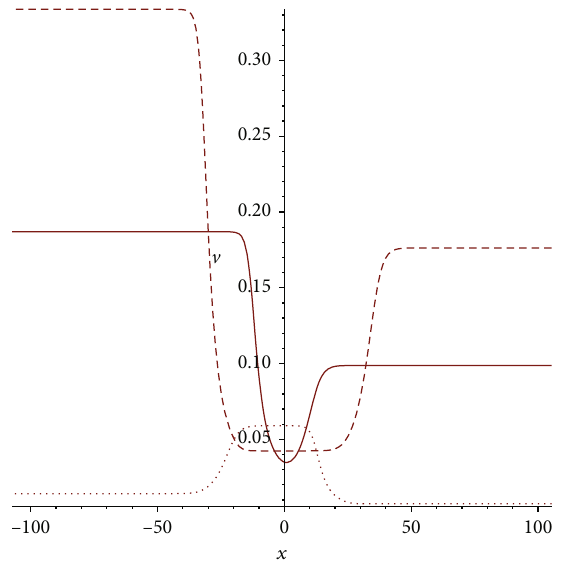
Figure 4: Two kinks for v ( t = − 200 for 10 7 v , linestyle is dot; t = 10 for v /10 , linestyle is solid; t = 200 for v /10 9 , linestyle is